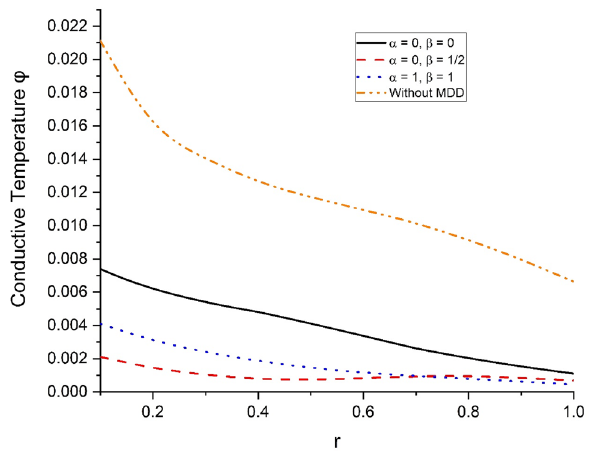
Fig. 5 Variations of normal stress t zz with radius r